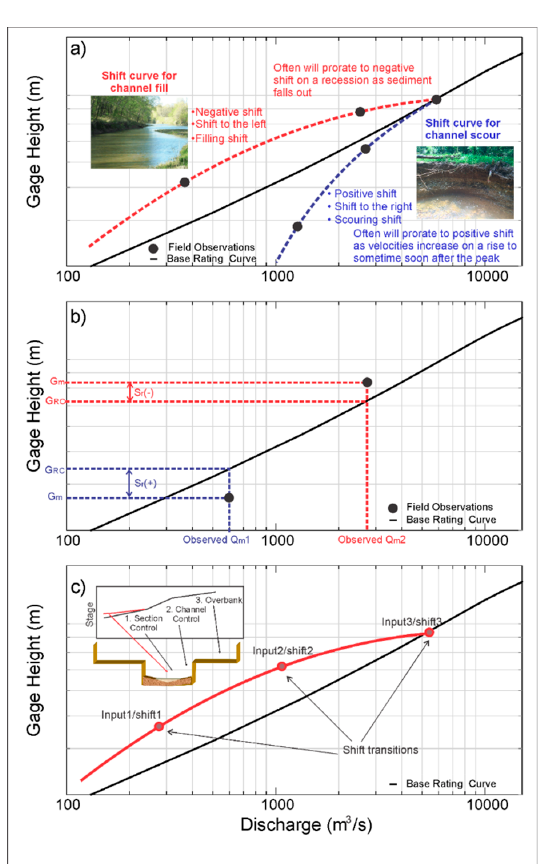
Figure 2. Rating curves adjusted from shifts: ( a ) base rating curve and adjustments for temporary changes; ( b ) shift value for stage–discharge ratings; and ( c ) adjusted rating curve–shift transitions.